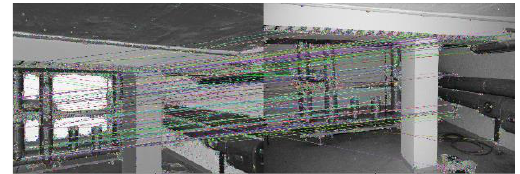
Figure 7. Feature matching using distance ratio test.